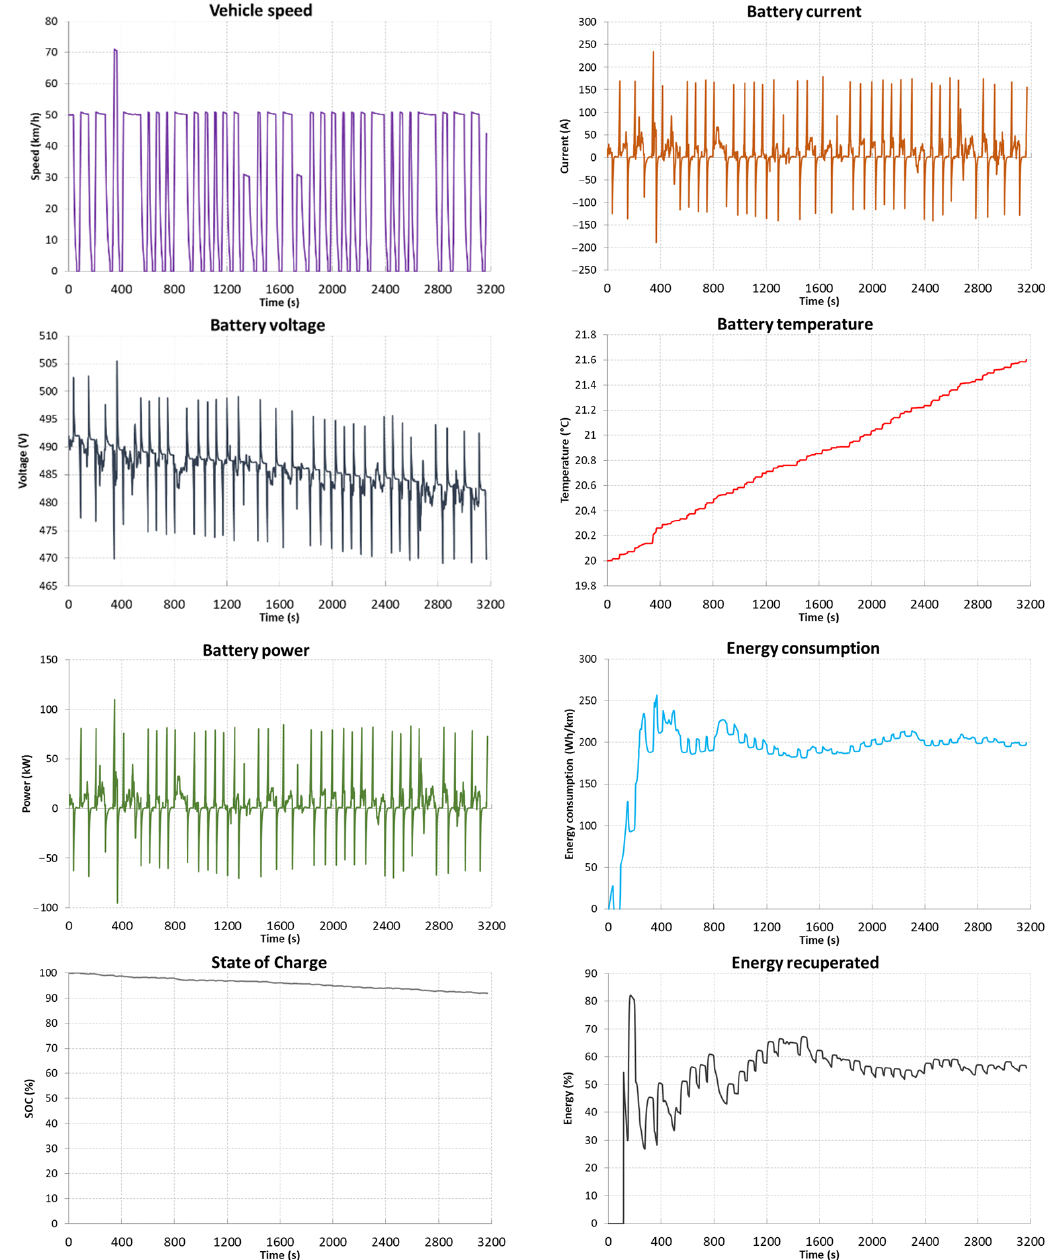
Figure 19. City Flat Road results of simulation tests for the 4 × 4 drive system with Type 3 energy storage.